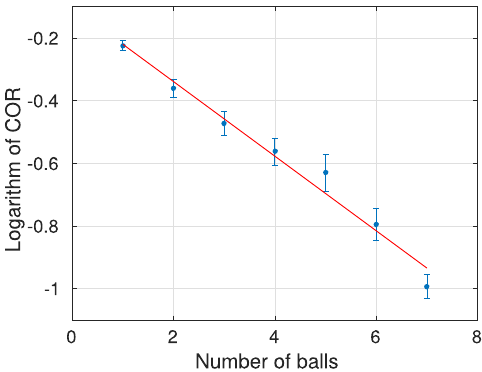
Fig. 8. The logarithm of COR values are shown on the y -axis and the number of balls are shown on the x -axis. The ball diameter was 12 mm, the number of magnets was 6 and a = 0.7. The linear regression, y = (cid:2) 0.12 n (cid:2) 0.08, is shown as a solid red line.